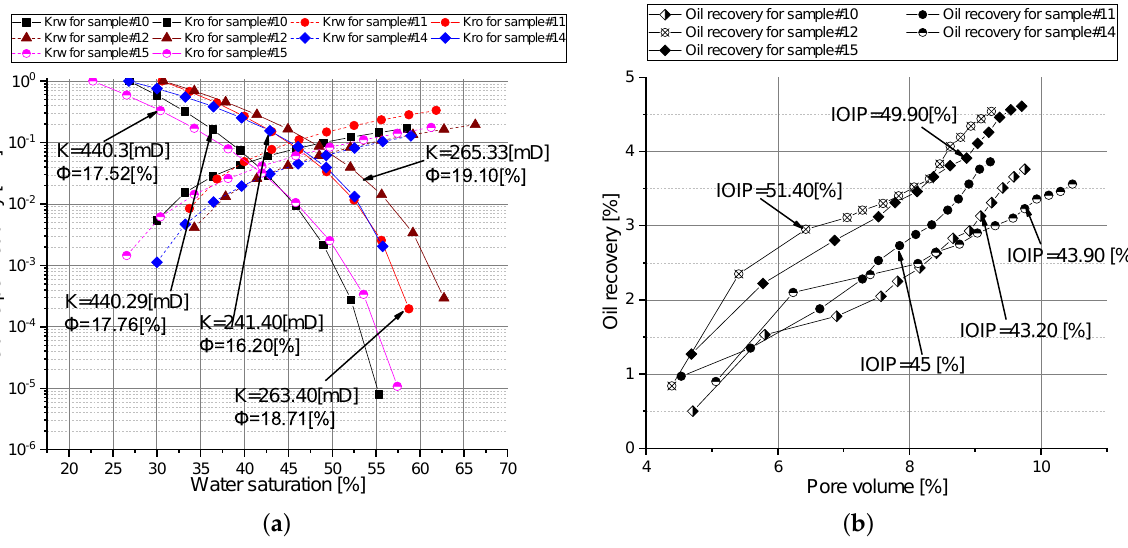
Figure 6. ( a ) Relative permeability versus water saturation indicating the effect of air permeability and porosity on the relative permeability and ( b ) Oil recovery versus pore volume highlighting the IOIP index impact for the studied